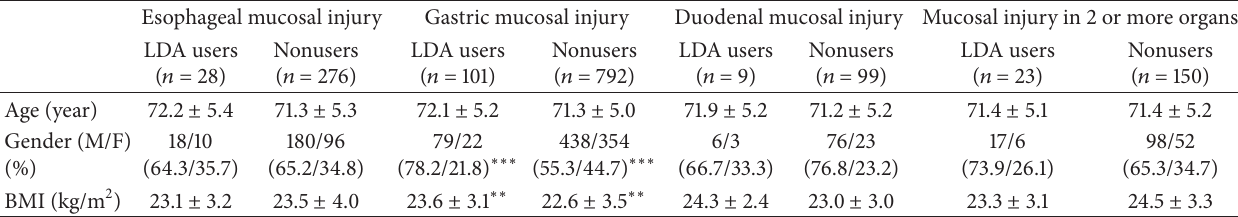
Table 1: Characteristics of subjects with mucosal injury in individual organs.